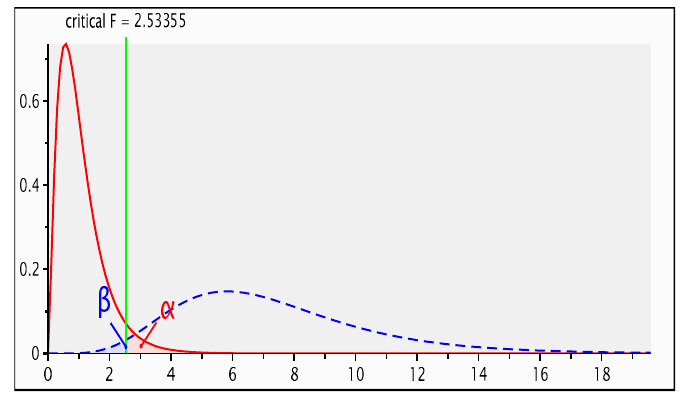
Figure 1. G-Power analysis for statistical power, effect and sample size.